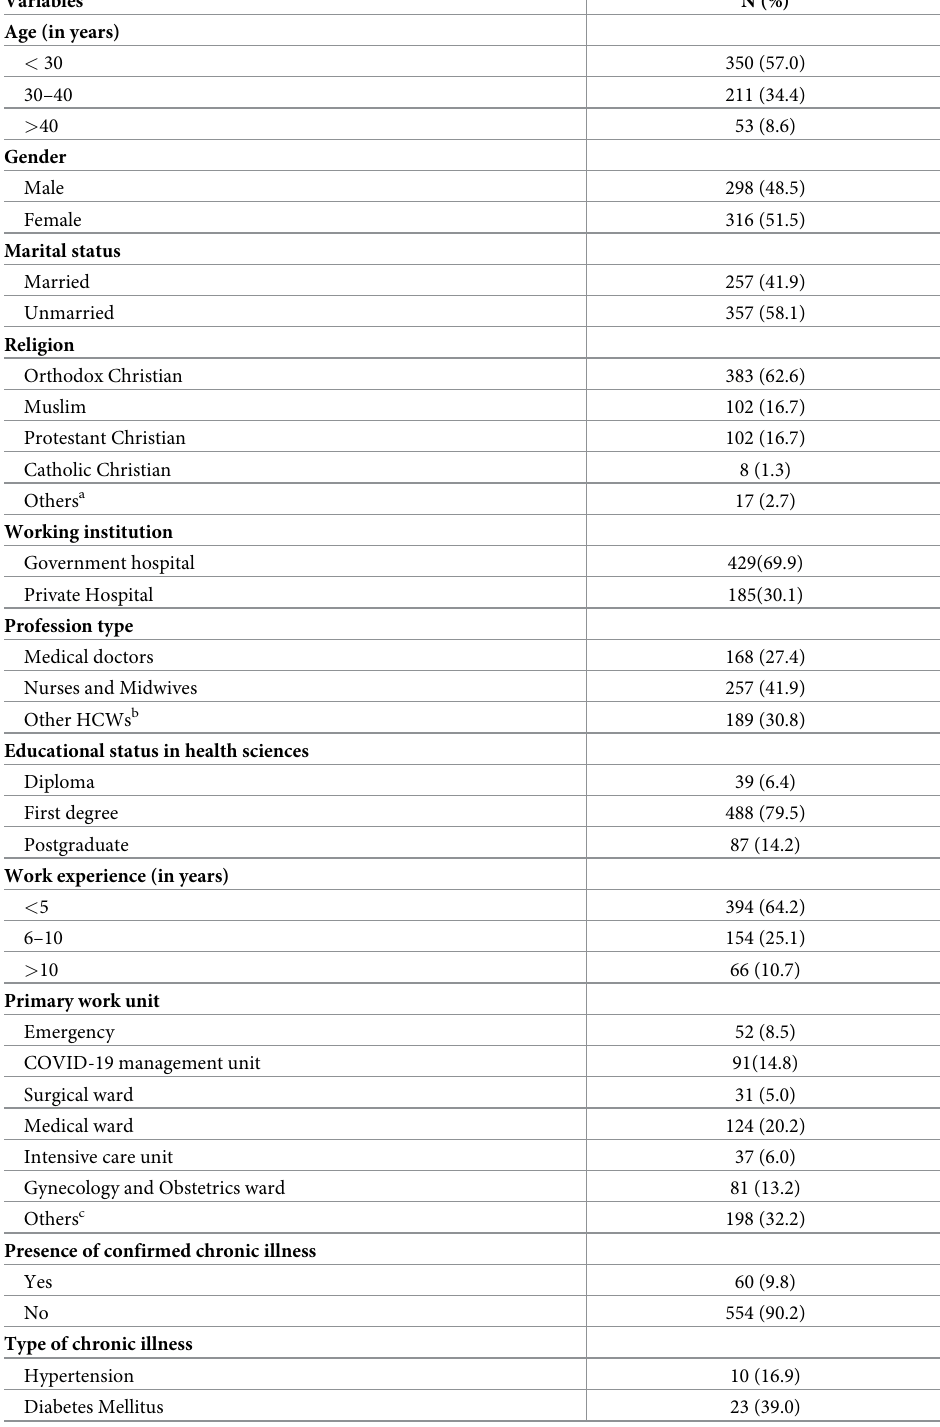
Table 1. Socio-demographic characteristics of study